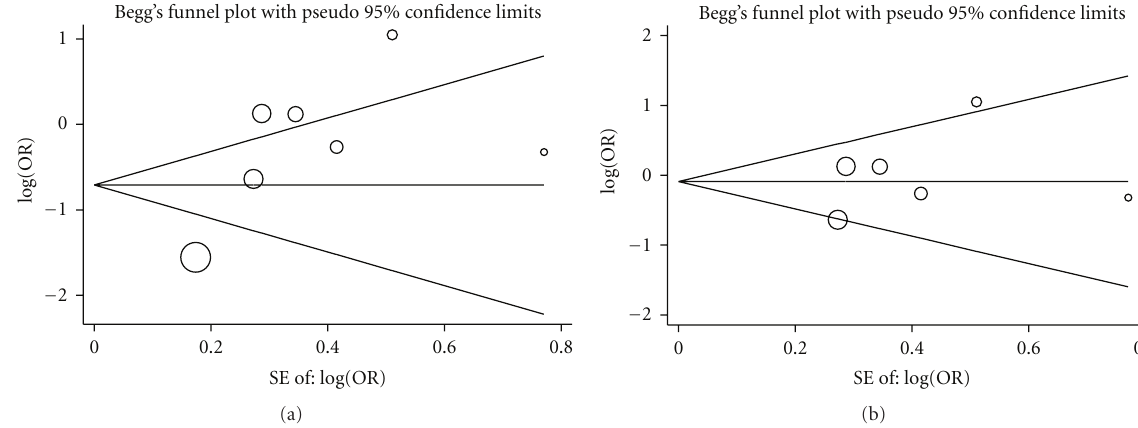
Figure 3: Funnel plots for studies investigating the e ff ect of ANP gene T2238C polymorphism on the risk of hypertension in overall allelic model (a) and after excluding the most influential study (b). Vertical axis represents the log of OR; horizontal axis represents the SE of log(OR). Funnel plots are drawn with 95% confidence limits. OR, odds ratio; SE, standard error. The graphic symbols represent the data in the plot sized proportional to the inverse